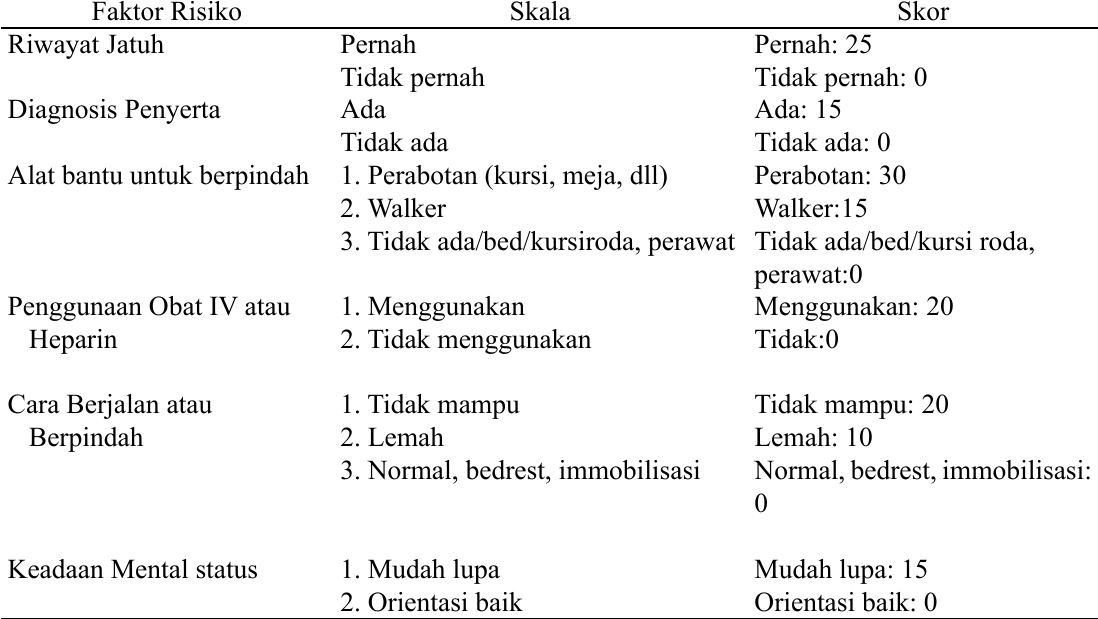
Tabel 3. Instrumen Penilaian dengan menggunakan Morse Fall Scale (Morse,